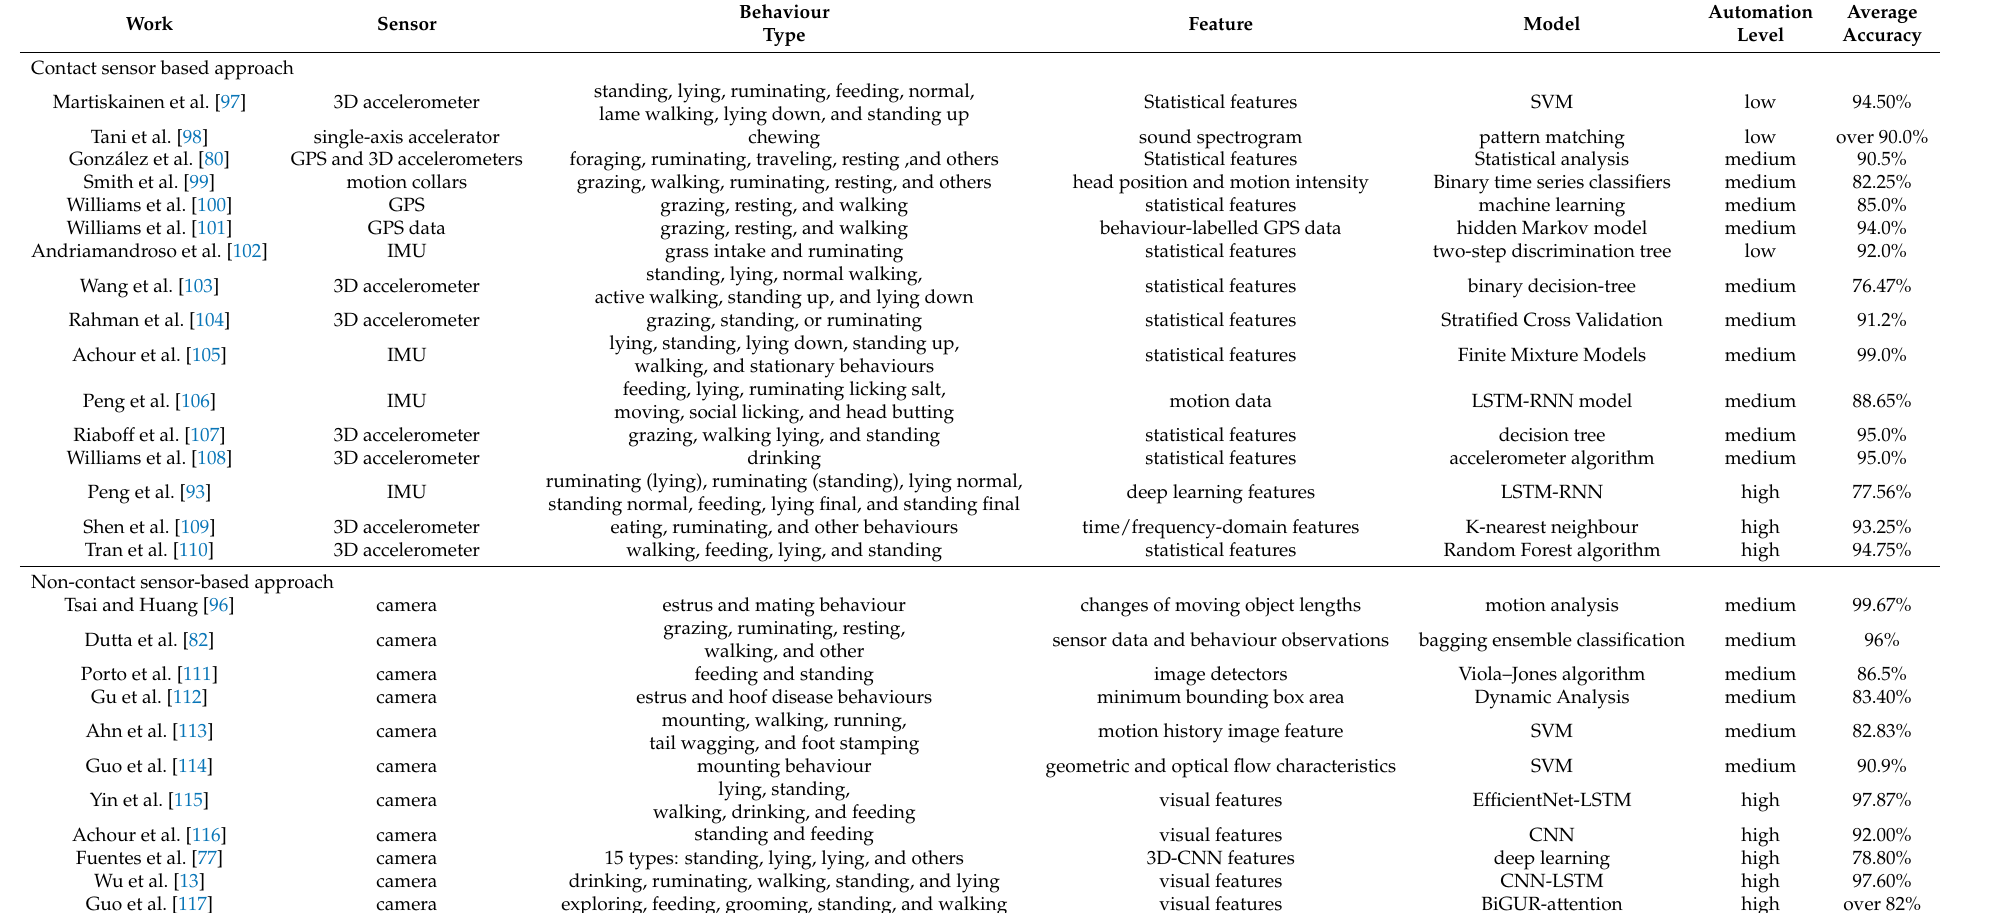
Table 3. Main studies on cattle behaviour